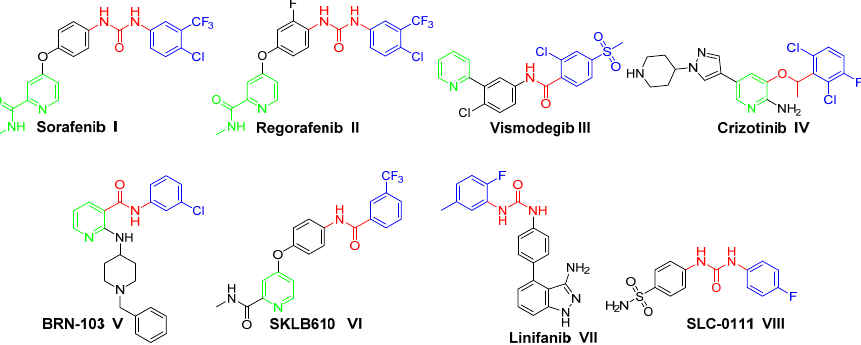
Figure 1. Structures of some pyridine ‐ /urea ‐ based approved anticancer drugs ( I – IV ), or in